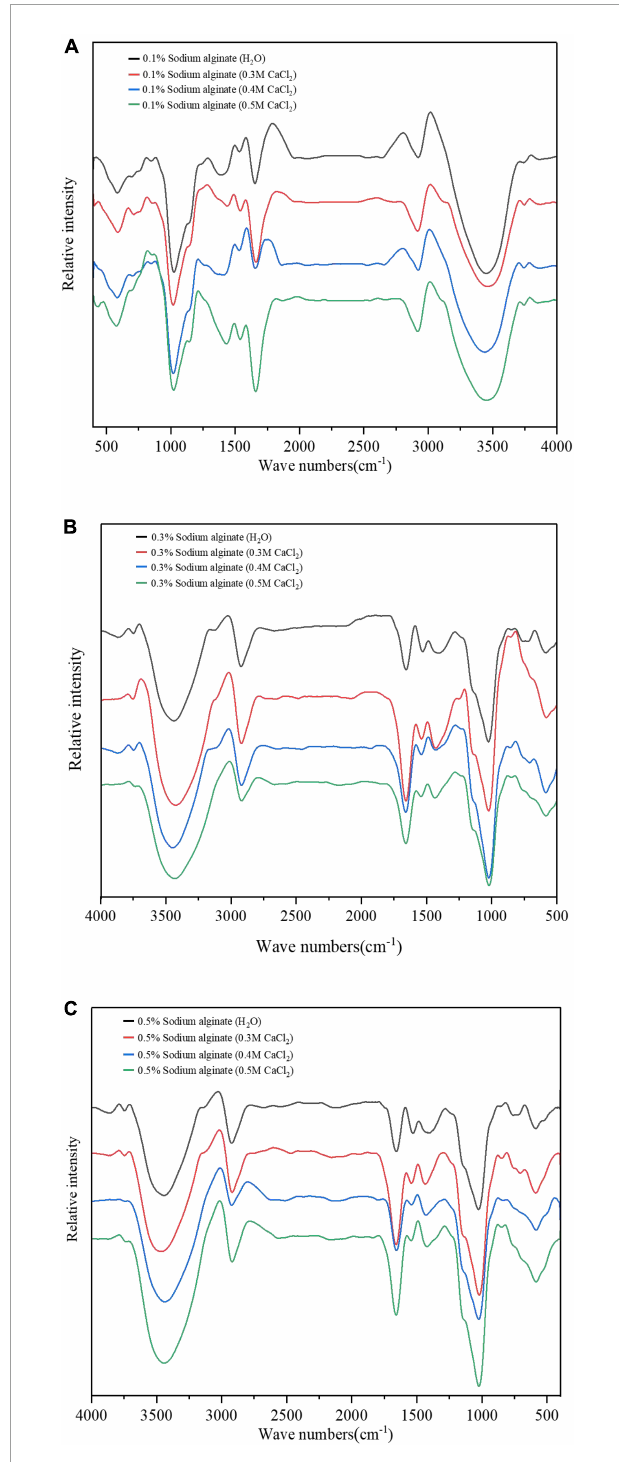
FIGURE6 (A–C) Show the Fourier transform infrared spectra of sodium alginate with the addition of varying Ca 2 + concentrations by the exogenous